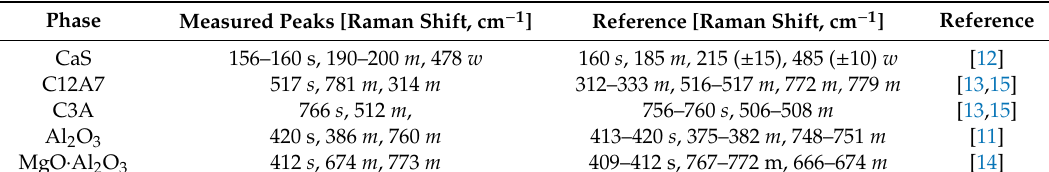
Table 3. Reference and measured Raman shift (cm − 1 ) for starting phases of CA, CaS, C12A7, C3A, Al 2 O 3 , and MgO · Al 2 O 3 (where s is strong, m is medium, and w is weak).